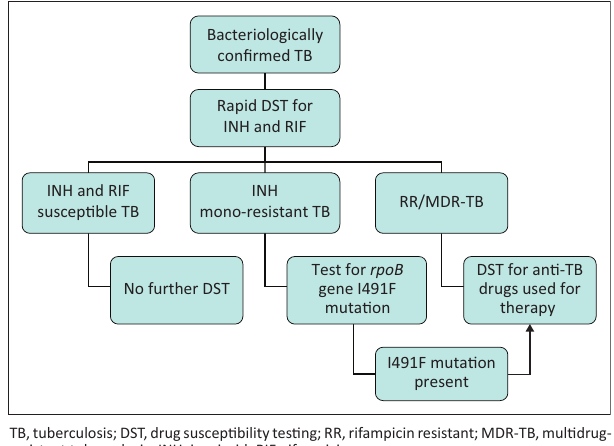
FIGURE 2: Proposed algorithm for the diagnosis of drug-resistant